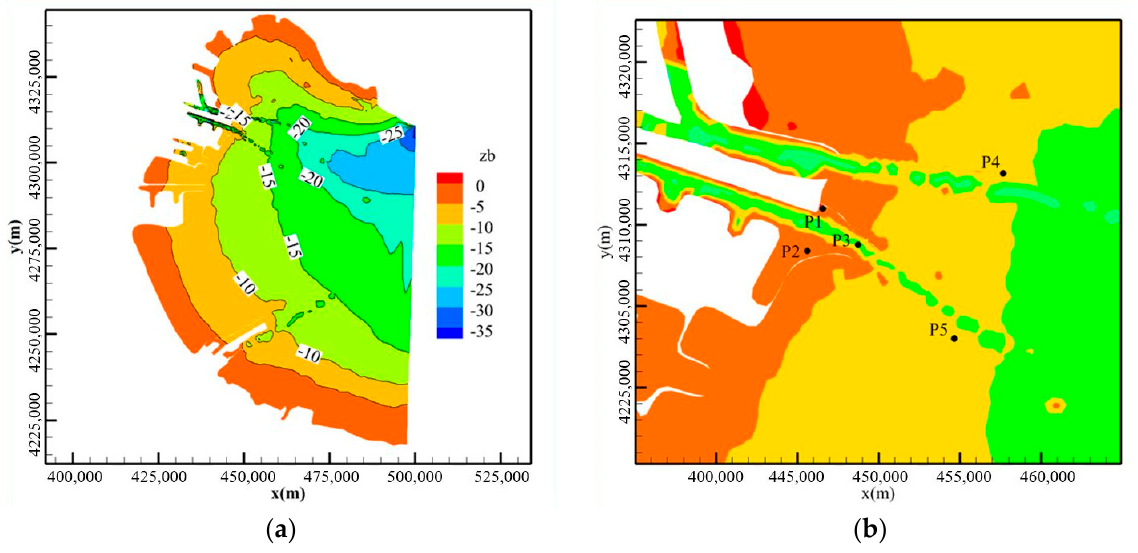
Figure 7. Computational domain geometry for tidal flow in the west region of Bohai Bay. ( a ) Computational domain geometry; ( b ) Gauge points.